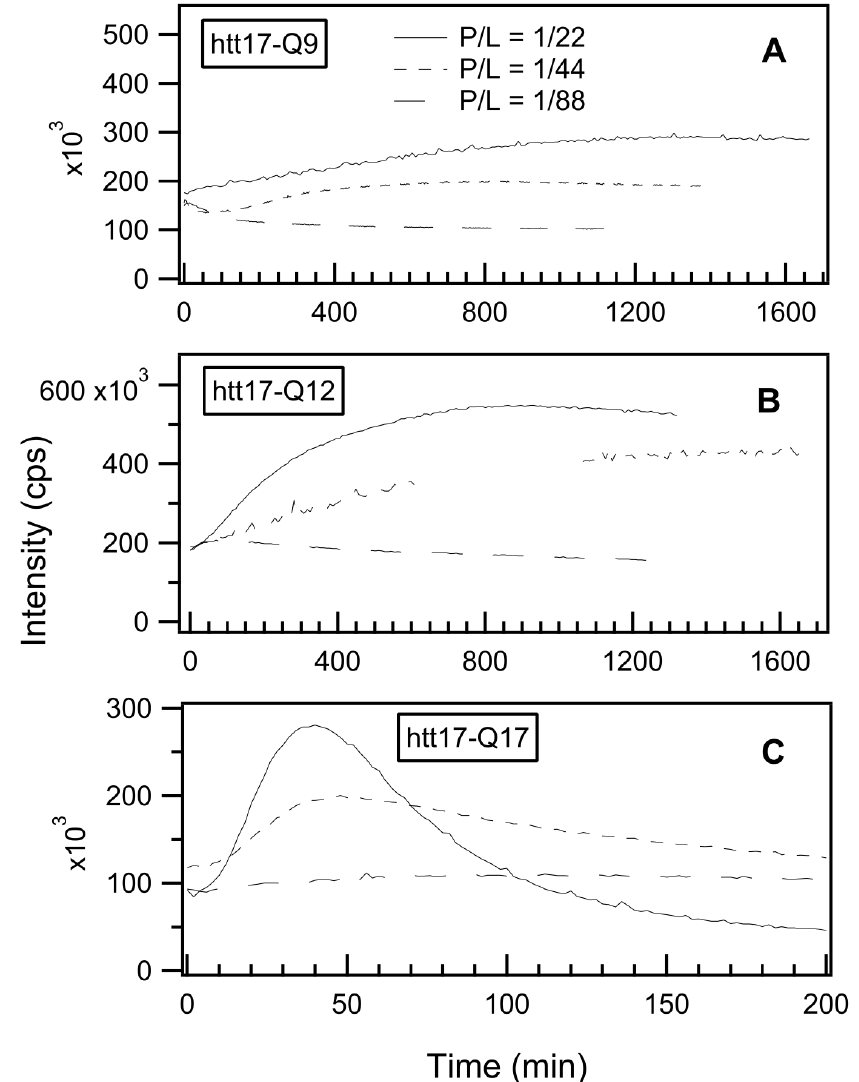
Figure 4. Time-dependent thioflavin T fluorescence as a function of polypeptide concentration: the thioflavin T fluorescence was continuously measured at 485 nm in the presence of SUVs and htt17-Q9 ( A ), htt17-Q12 ( B ), or htt17-Q17 ( C ), in 10 mM Tris-HCl, pH7. The peptide-to-lipid molar ratios are 1/22, 1/44, and 1/88, displayed as solid, short-dashed, and long-dashed lines, respectively. The lipid concentration was kept constant (C ≈ 320 µ M) while the amount of peptide was adjusted to obtain the P/L ratios indicated. The ThT concentration was ≈ 5 µ M in all the